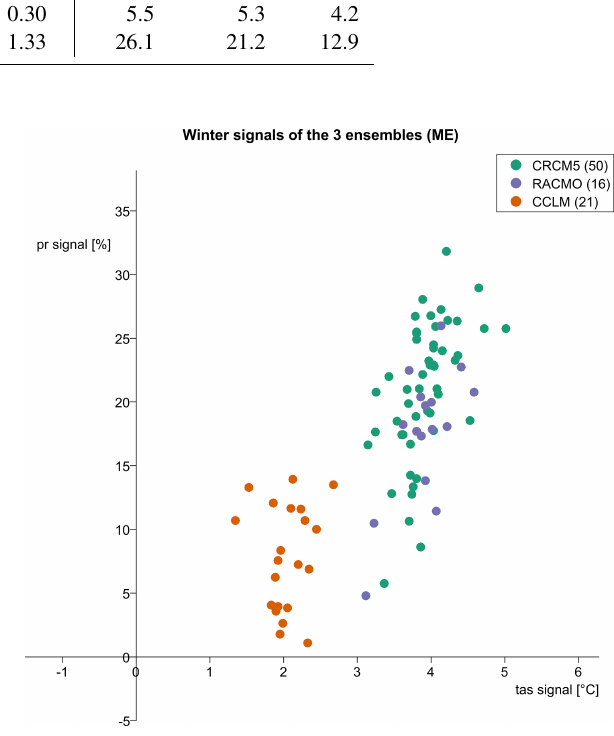
Figure 2. Change in mean summer temperature and precipitation for every member of the three ensembles in mid-Europe (2070– 2099 against 1980–2009). Changes are relative to each members’ value in 1980–2009 for precipitation, while temperature changes are absolute.